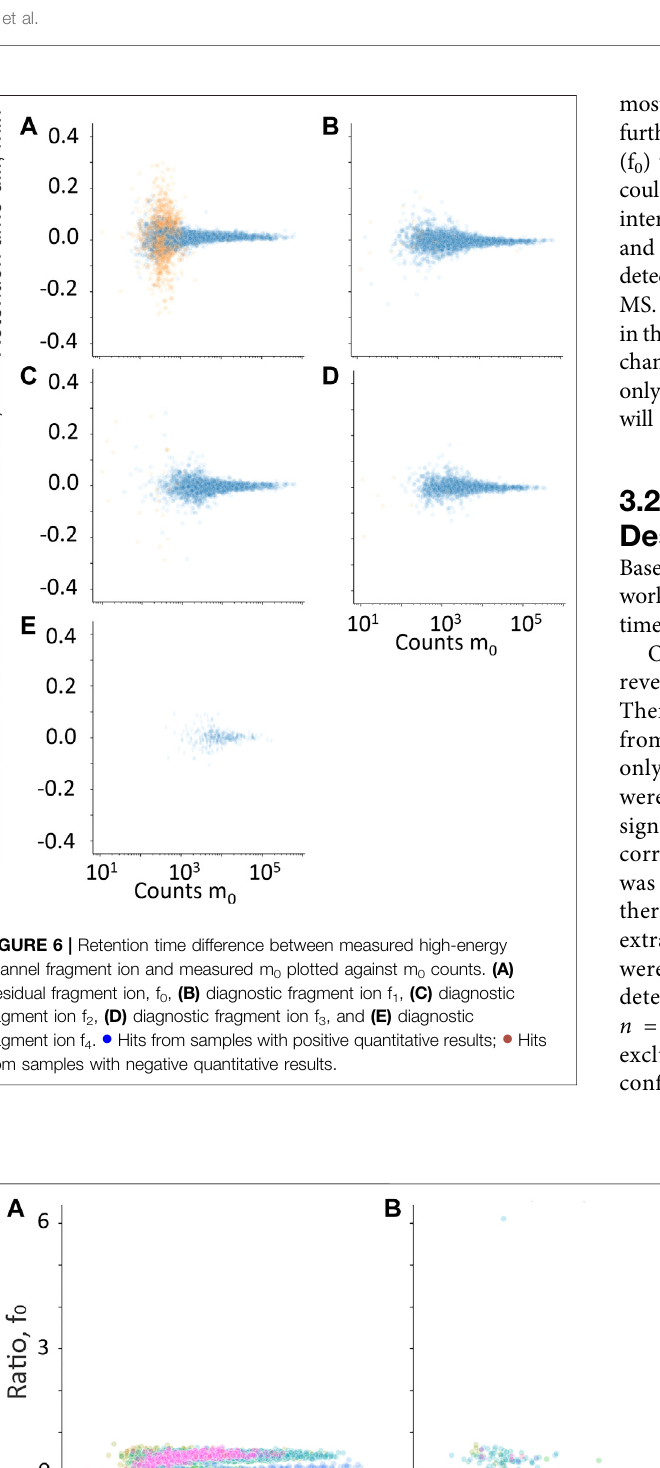
FIGURE 7 | Ratio between residual precursor ion, f 0 , and m 0 plotted against counts of m 0 . (A) Hits from samples with positive quantitative results; (B) hits from samples with negative quantitative result.